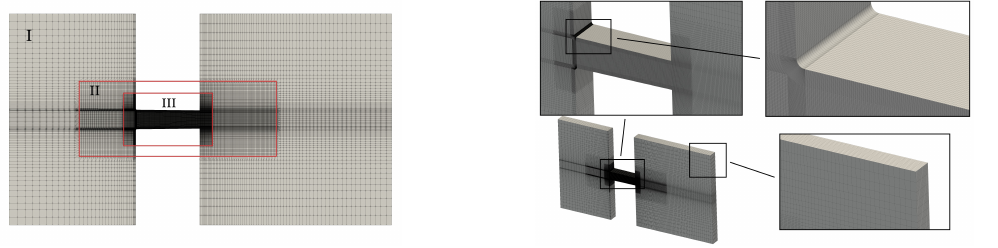
Figure 20. Polyhedral mesh with 5 M cells used for the simulations. Refinement regions (labelled as II and III) are applied in proximity to the nozzle region.